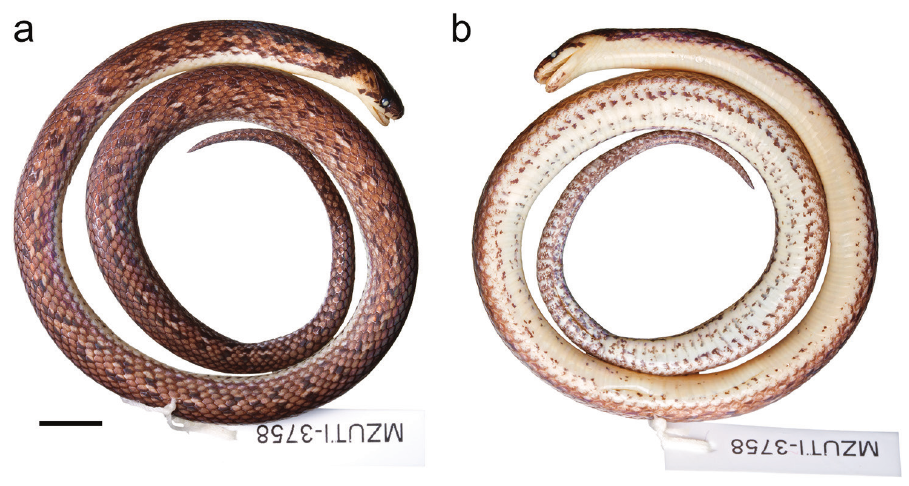
Figure 6. Adult male holotype of Atractus esepe MZUTI 3758 in dorsal ( a ) and ventral ( b ) view. Scale = 1